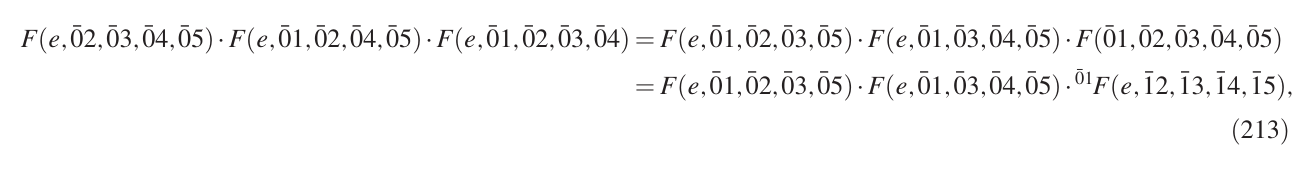
¯01 F 12345 . We use a simpler notation F ijklm ¼